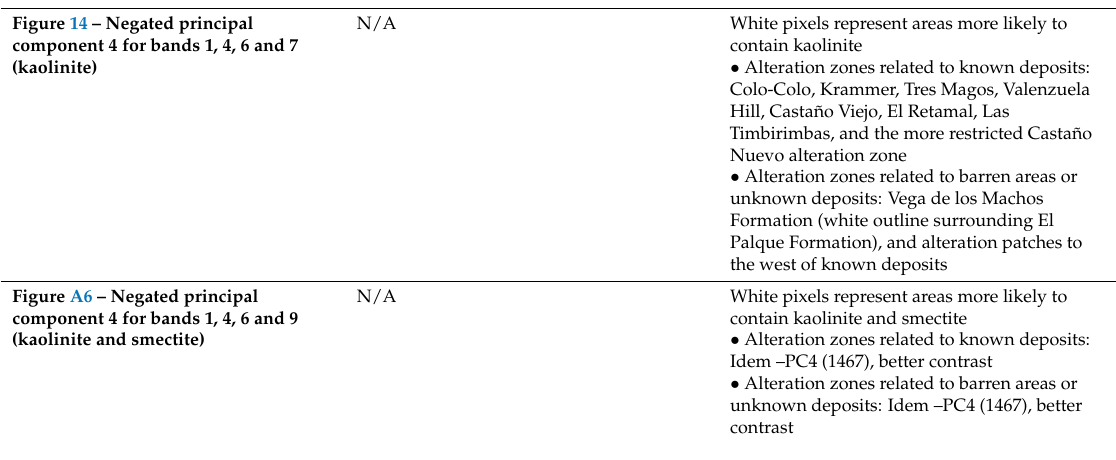
Figure 14 – Negated principal component 4 for bands 1, 4, 6 and 7